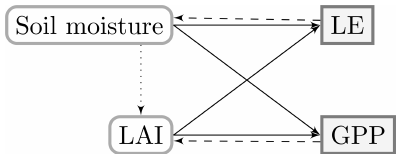
Figure 1. First-order relations (plain lines) and feedbacks (dashed lines) of the state variables and surface fluxes in prognostic LSMs. The feedback mechanisms are not present in diagnostic models, and the soil moisture–LAI relation (dotted line) occurs only in prognos- tic LSMs with dedicated phenology